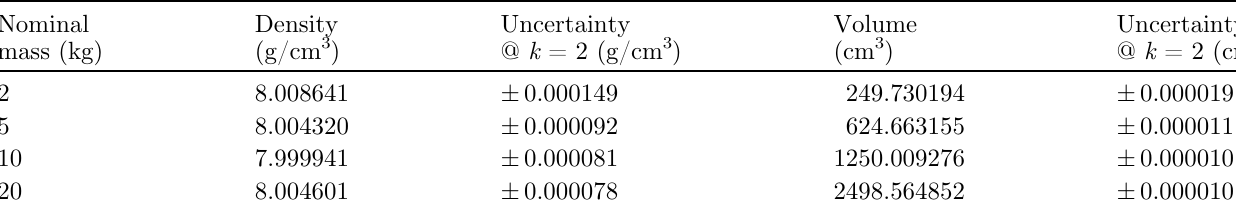
Table 1. the density, volume and their associated uncertainties values obtained for the masses from 2 kg to 20 kg.